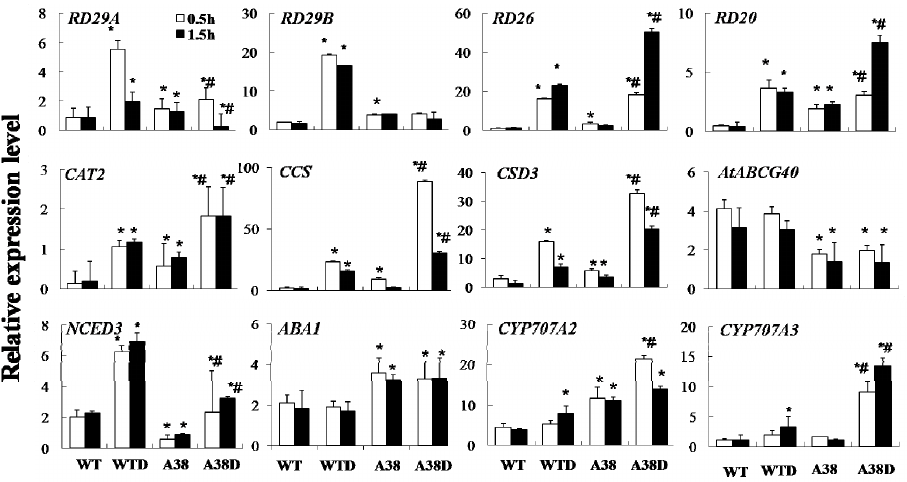
Figure 2. Expression analyses of related genes in A38 lines and wild-type. The transcript level of RD29A , RD29B , RD26 , RD20 , ABA1 , AtABCG40 , NCED3 , CYP707A2 , CYP707A3 , CAT2 , CCS and CSD3 were examined by quantitative PCR analysis in 14 day-old plants. A38 and WT seedlings were grown on MS agar medium with or without dehydration treatment at the time points indicated. 18SrRNA gene expression level was used as an internal control. Error bars represent standard deviation among the three reduplicate experiments. WT represents wild-type plants under normal conditions; WTD represented wild-type plants that were treated with dehydration for 0.5 h or 1.5 h; A38 represented A38 lines under normal conditions; A38D represented A38 lines that were treated with dehydration for 0.5 h or 1.5 h. * indicated that values of the WTD, A38 and A38D were significantly different from those of WT with p < 0.05, after dehydration for 0.5 h or 1.5 h, respectively. # indicated that values of A38D were significantly different from A38 at p < 0.05 after dehydration for 0.5 h or 1.5 h,